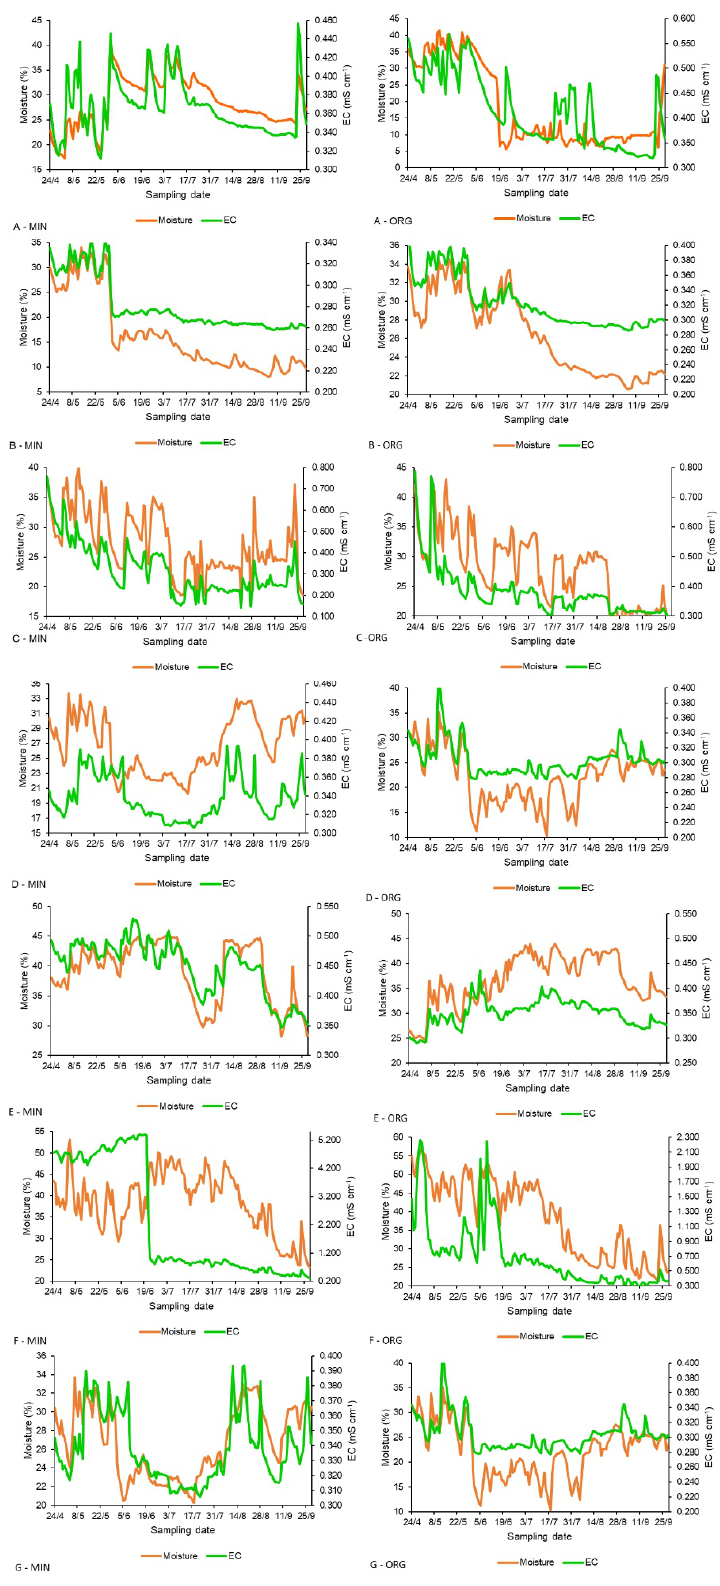
Figure 2. Trend of soil electric conductivity (EC) and moisture in mineral (MIN) and organic (ORG) fertilized plots in apricot ( A ), peach ( B ), plum ( C ), apple ( D ), pear ( E ), yellow kiwifruit ( F ) and green kiwifruit ( G ) orchards during the season.